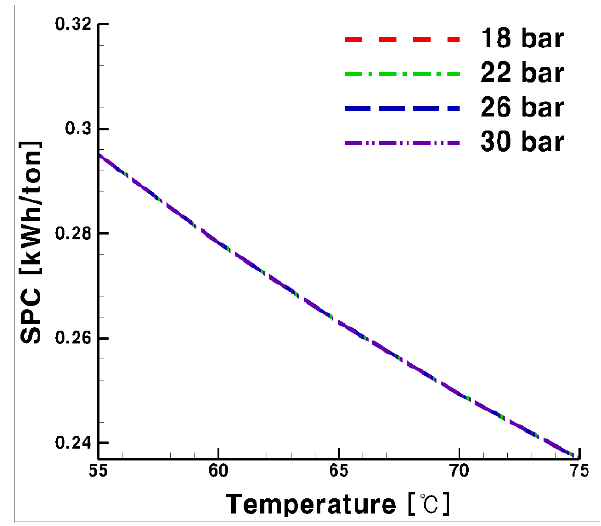
Figure 3. Changes in specific power consumption (SPC) as a function of temperature in front of the LNG HEX2 heat source when using glycol water as the heat medium.